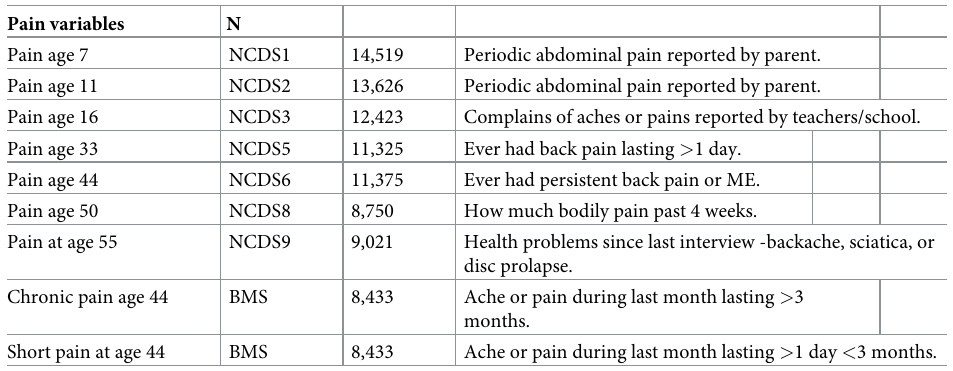
Table 4. Pain Variables in